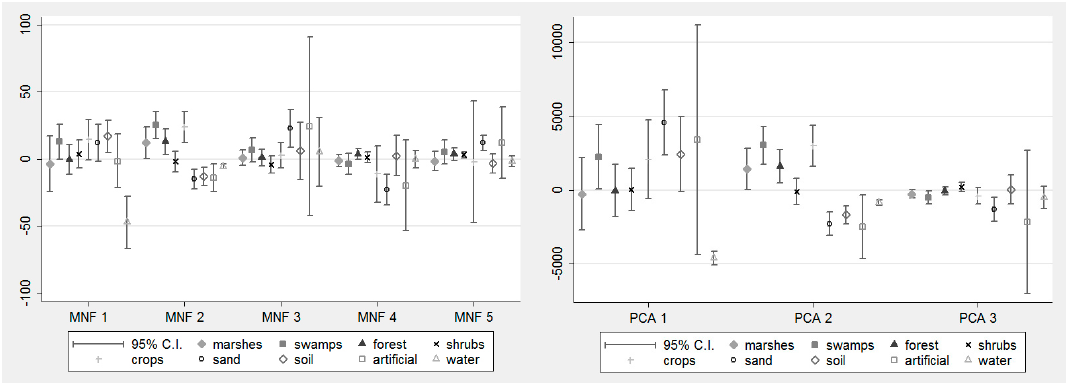
Figure 3. Spectral mean values of: Principal Component Analysis (PCA) ( left ); and Minimum Noise Fraction (MNF) ( right ) components. Vertical axis represents the transformed values in both charts.